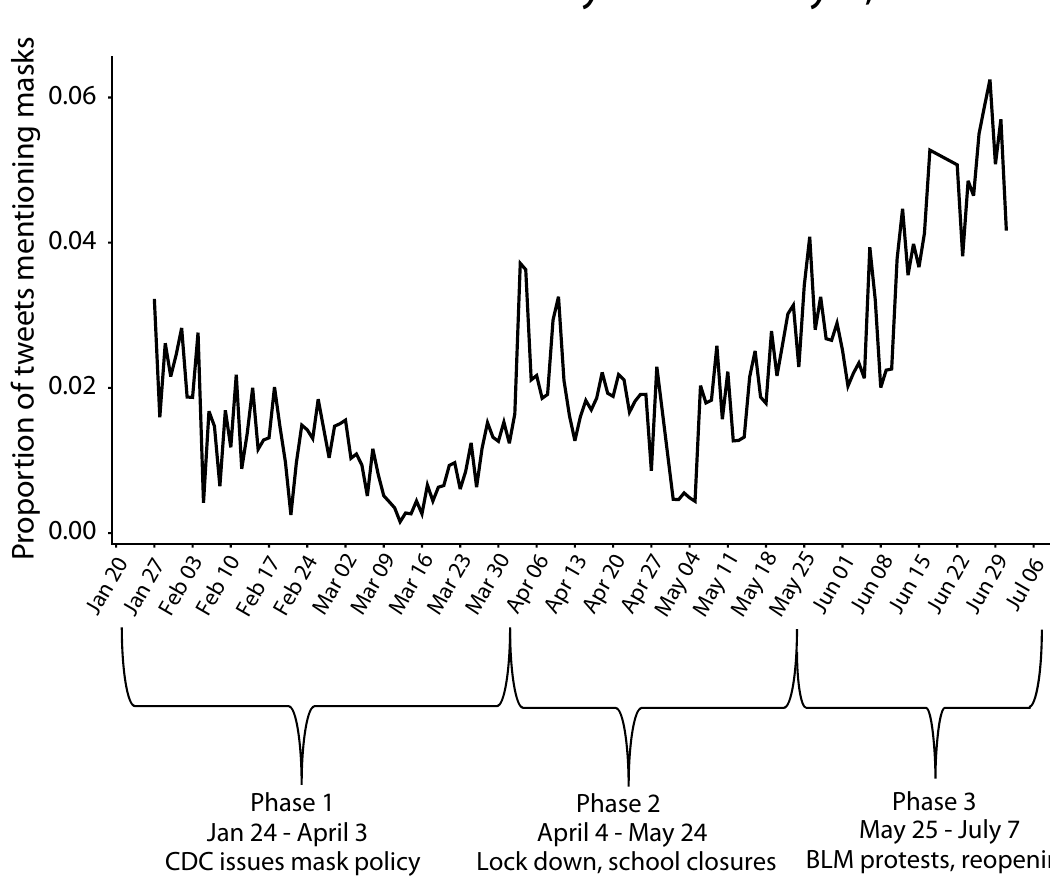
Fig 1. Proportion of mask tweets ( N = 7024) of 592,317 COVID-19 tweets between January 24 and July 7, 2020 across pandemic phases.